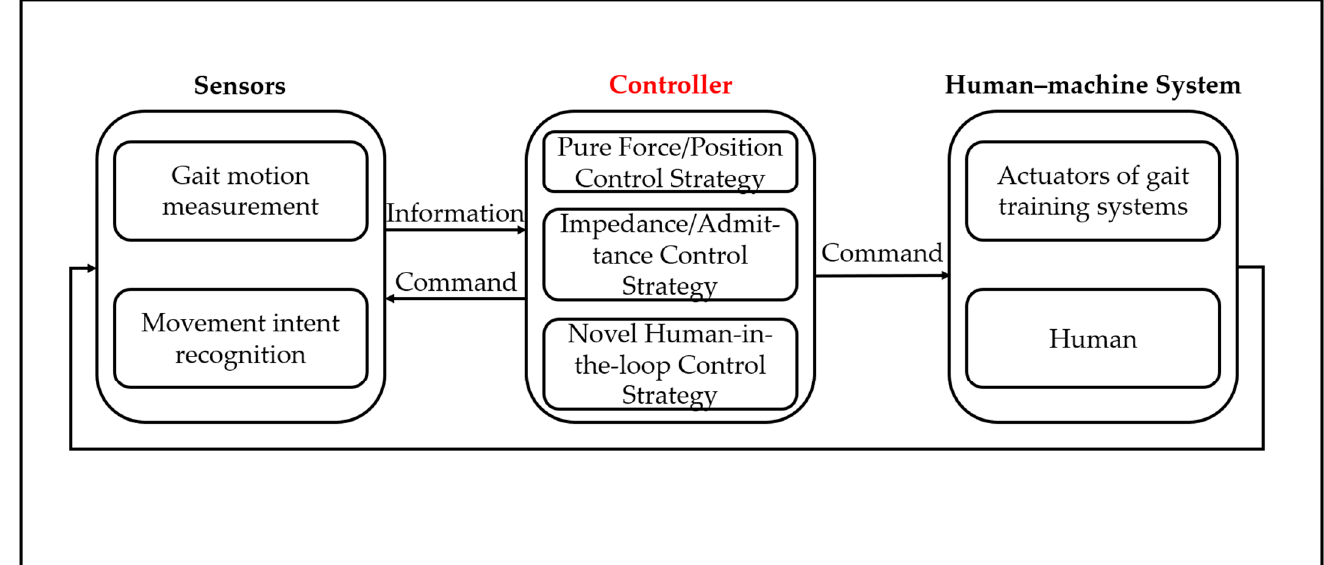
Figure 2. Typical control diagram of gait training systems.